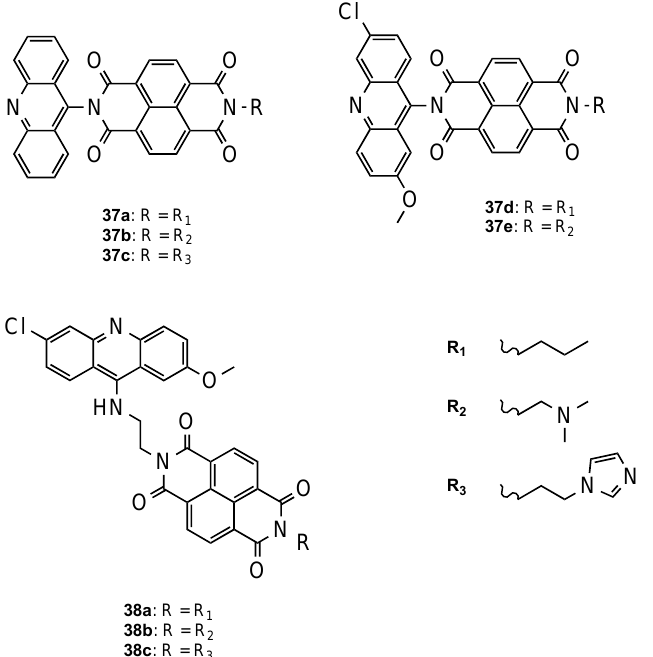
Figure 24. Orthogonal ( 37a – e ) and flexible ( 38a – c ) series of NDI – acridine hybrids developed by Dana and co-workers [54].